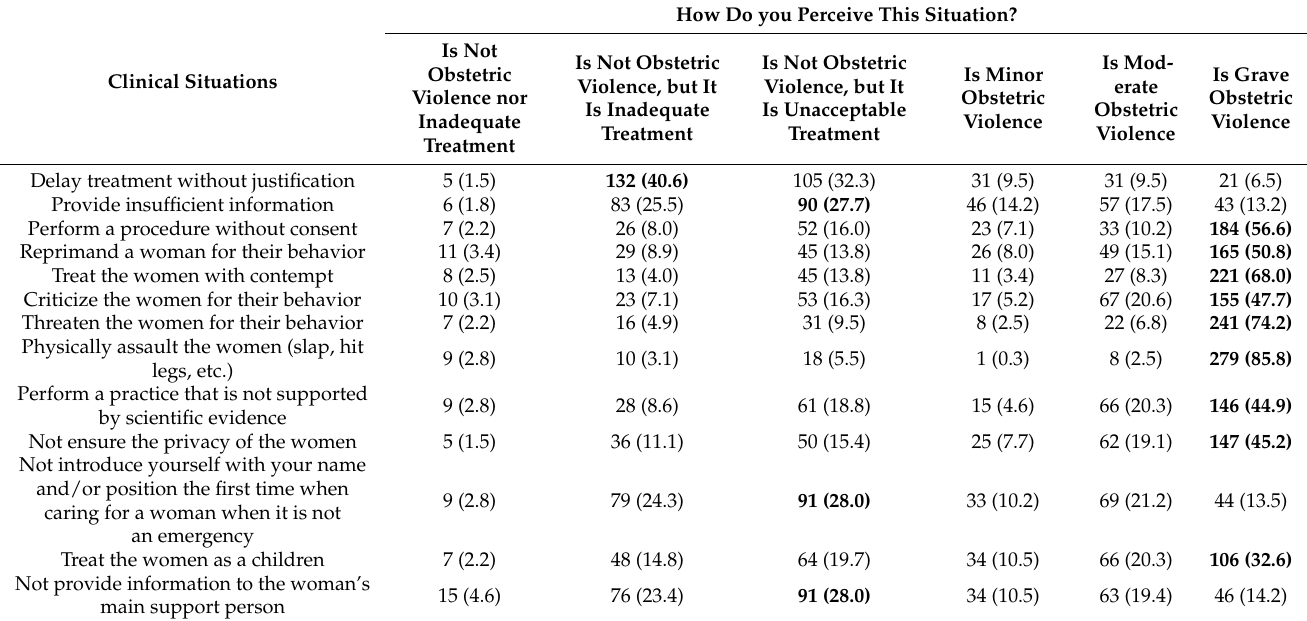
Table 3. Perception of the study midwives of specific situations in clinical